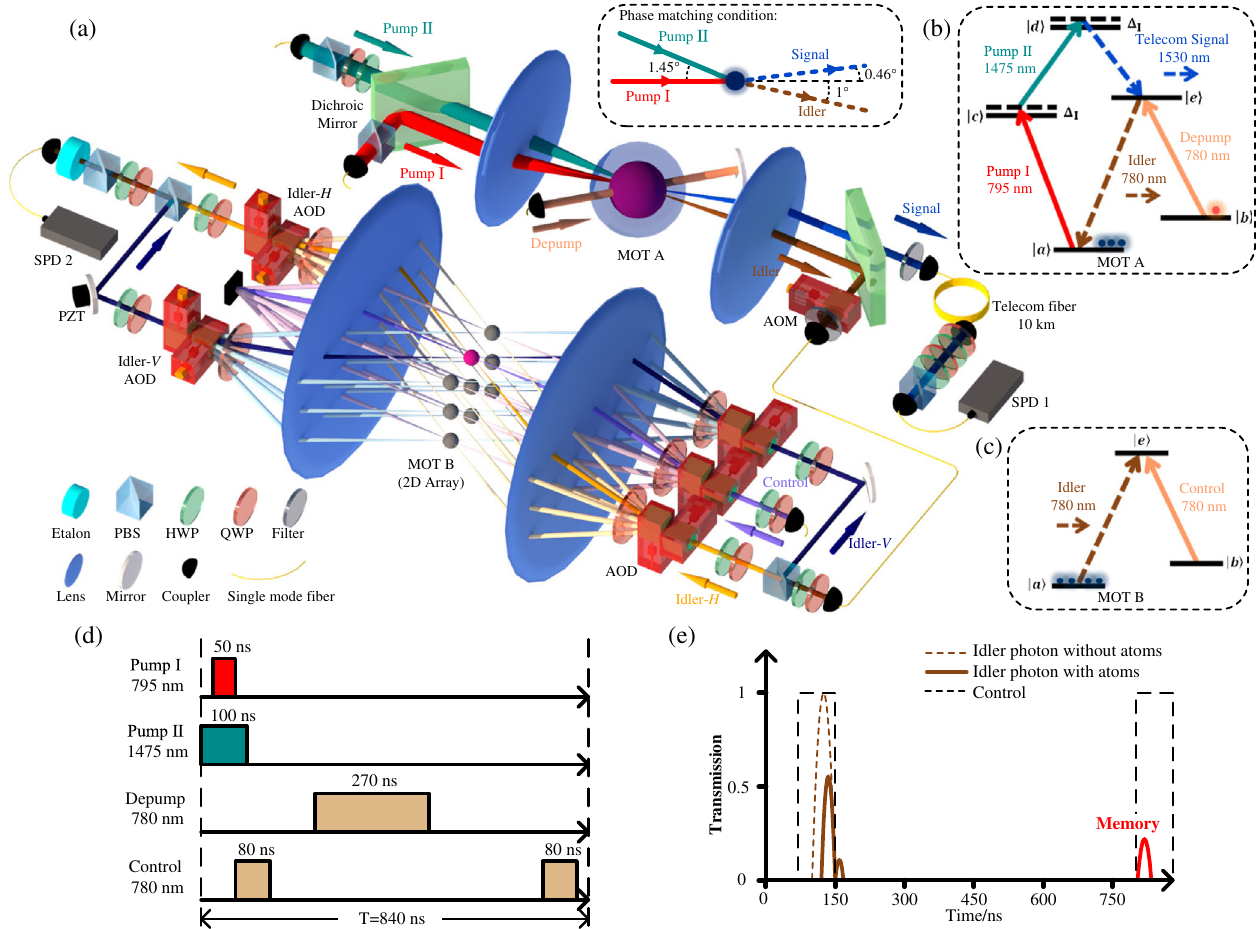
FIG. 1. Experimental setup for a multiplexed quantum memory entangled with a telecom photon. (a) The pump I beam (795 nm) with horizontal polarization and the pump II beam (1475 nm) with vertical polarization excite the atoms in MOT A and generate a pair of entangled photons with 780-nm (signal) and 1530-nm (idler) wavelengths. A depump beam is used to pump the atoms leaked into the j b i state back to the initial ground state during the experimental cycle as shown in panels (b) and (e). The signal photon is coupled to a 10-km telecom fiber for long-distance transmission and is then directed into a single-photon detector (SPD1) for detection. A quarter- wave plate (QWP), a half-wave plate (HWP), and a polarizing beam splitter (PBS) are inserted before the detector to select the measurement basis for quantum state tomography. The idler field is divided by a PBS into two polarization components (idler H and idler V ), which are then directed by two sets of multiplexing AODs, respectively, to the 7 × 7 memory cells in a macroscopic atomic ensemble in MOT B for storage. For clarity, only 3 × 3 memory cells are drawn in the figure. The photon retrieved by the control beam from each memory cell is redirected by the two sets of demultiplexing AODs on the other side. Two polarization components of the retrieved field are further combined by a PBS and coupled to a single-mode fiber for detection (SPD2). A set of QWP, HWP, and PBS is also inserted here to select the measurement basis. The lens are set in a 4 f configuration to map different angles of the deflected beams from the AODs to different memory cells as well as to focus the beams. A Fabry-Perot cavity (etalon) is used for filtering out the diffracted control beam by frequency selection in the path of the retrieved photon. The power of the pump I, pump II, depump, and control beams are 0.1, 1.2, 5, and 0.2 mW, respectively. (b) The energy-level diagram of 87 Rb atoms for the generation of two-color ; F ¼ 1 i , j b i ¼ j 5 S 1 ; F ¼ 2 i , j c i ¼ j 5 P 1 ; F ¼ 2 i , polarization-entangled photons in a diamond configuration, with j a i ¼ j 5 S 1 = 2 = 2 = 2 j d i ¼ j 4 D ¼ 3 i , and j e i ¼ j 5 P ¼ 2 i . The detuning of pump I from the j a i ↔ j c i transition is Δ ¼ 10 MHz, while pump II 3 = 2 ; F 3 = 2 ; F I is on resonance with the j c i ↔ j d i transition. (c) The energy-level diagram of 87 Rb atoms for the EIT storage of the idler photon. (d) The simplified timing sequence of the experimental cycles. All the laser pulses are modulated by the acoustic-optic modulators (AOMs). Pump I (50 ns) and pump II (100 ns) generate the polarized photon pair. The control beam is used to store and retrieve the idler photon in MOT B through the EIT process. The depump beam (270 ns) comes after the pumping process to bring the leaked atoms in MOTA back to the initial state j a i . (e) A schematic for the signal measured by SPD2. The timing of the control pulses is illustrated by the dashed rectangles; the solid brown curve represents the leaked idler photon after the absorption from the atom ensemble, compared with the dashed brown curve without the atoms. The larger solid brown peak represents a larger leakage when the control beam is on compared with the smaller one on the right when the control beam is off. The solid red curve is the retrieved photon after a storage time of 650 ns. Appropriate timing is chosen such that the first control pulse and the idler photon arrive at the memory